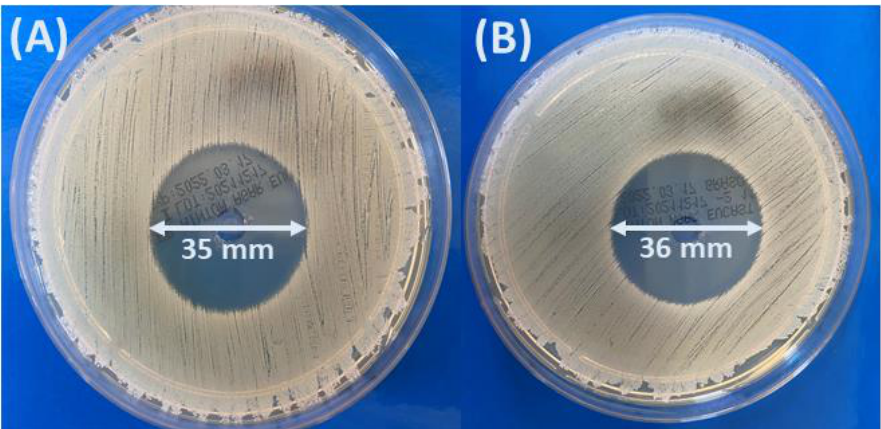
Figure 13. Inhibition zones of Staphylococcus aureus (ATCC 25923) after culture with the rifampicin released from the SEB_20_3 ( A ) and SEB_80_3 ( B ) microspheres after 24 h into the